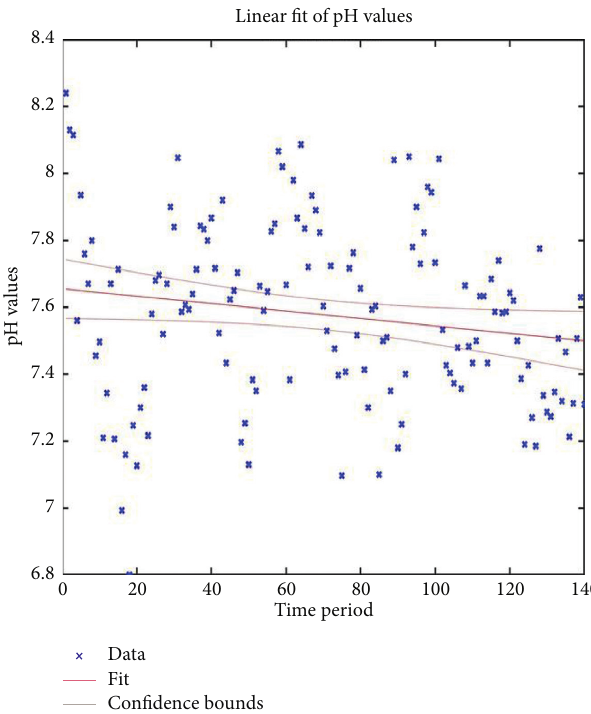
Figure 12: Linear regression fit of pH values at